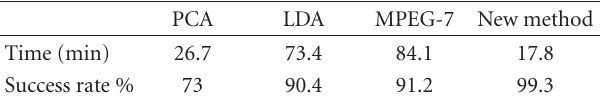
Table 11: The time consumed (in minutes) and the success recognition rate for the di ff erent methods using the xm2vts (C1) database.